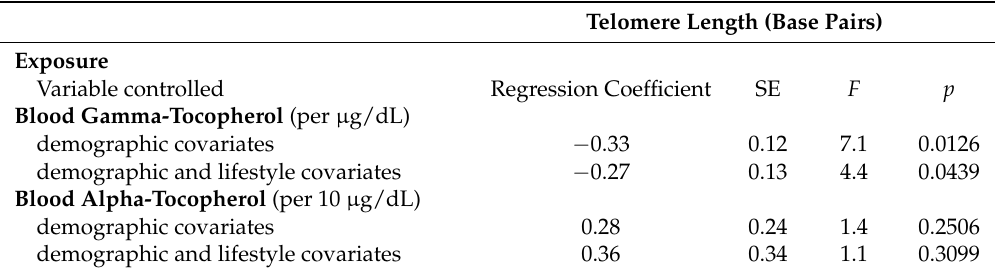
Table 3. Relationship between gamma- and alpha-tocopherol blood levels and telomere length (base pairs) in 5768 US adults, independent of